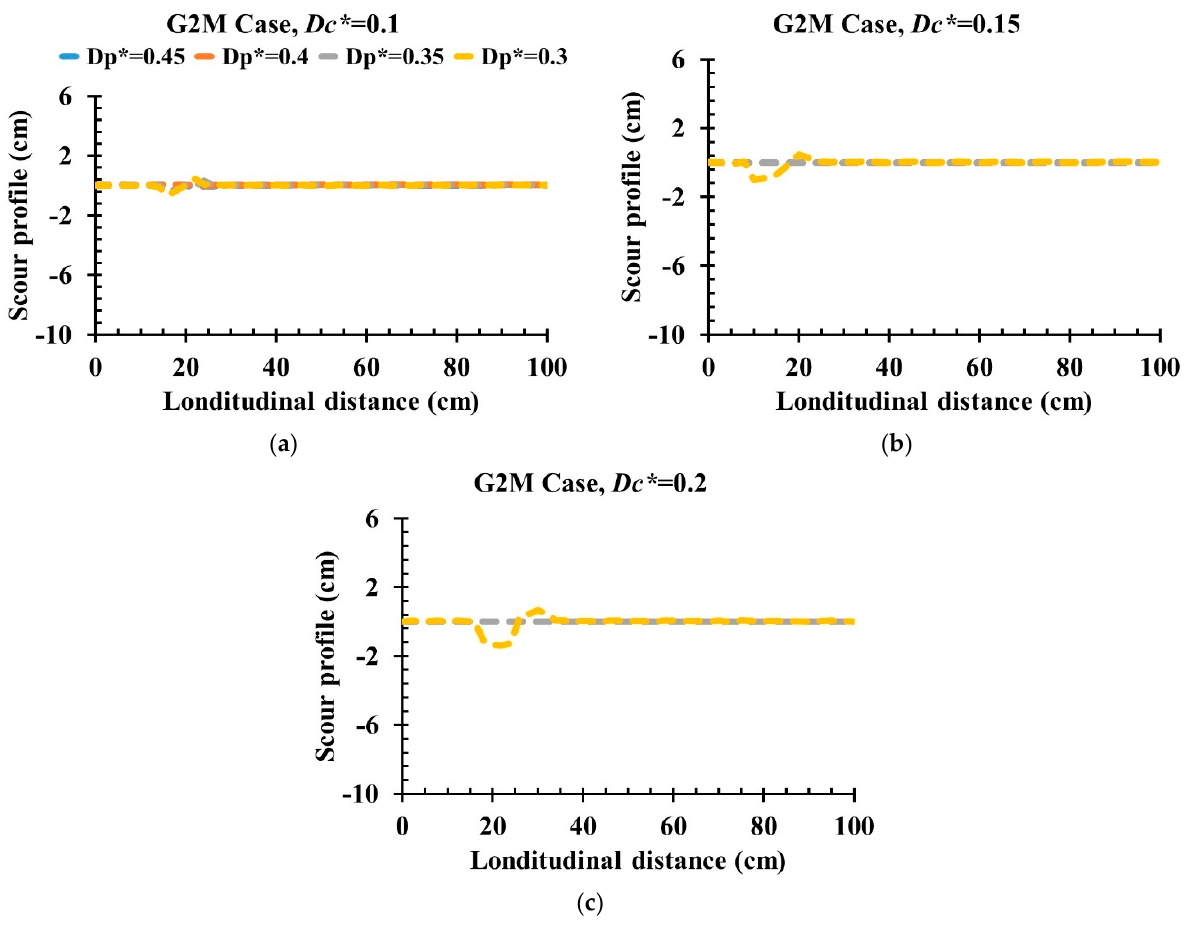
Figure 7. ( a ‐ c ) Scour profile during G2M case: (geogrid.2 case with aperture 2.5 mm): ( a ) 𝑫 𝒄 ∗ = 0.1; ( b ) 𝑫 𝒄 ∗ = 0.15; ( c ) 𝑫 𝒄 ∗ = 0.2.